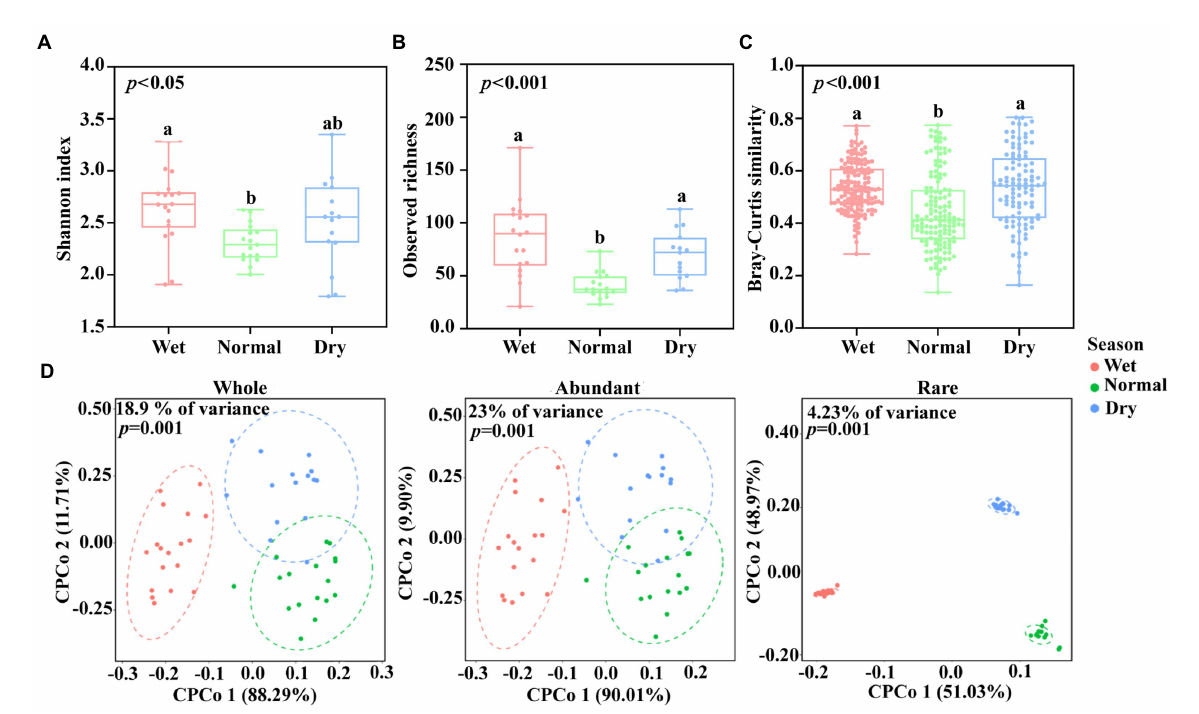
FIGURE 2 Dynamics of (A) Shannon index, (B) Observed richness, and (C) Bray–Curtis similarity of DAMO bacterial communities during wet, normal, and dry seasons. Different letters indicated significant difference by Duncan test ( p < 0.05). (D) Constrained principal coordinate analysis (CPCoA) plot based on Bray-Curtis distance showing the variation of DAMO bacterial